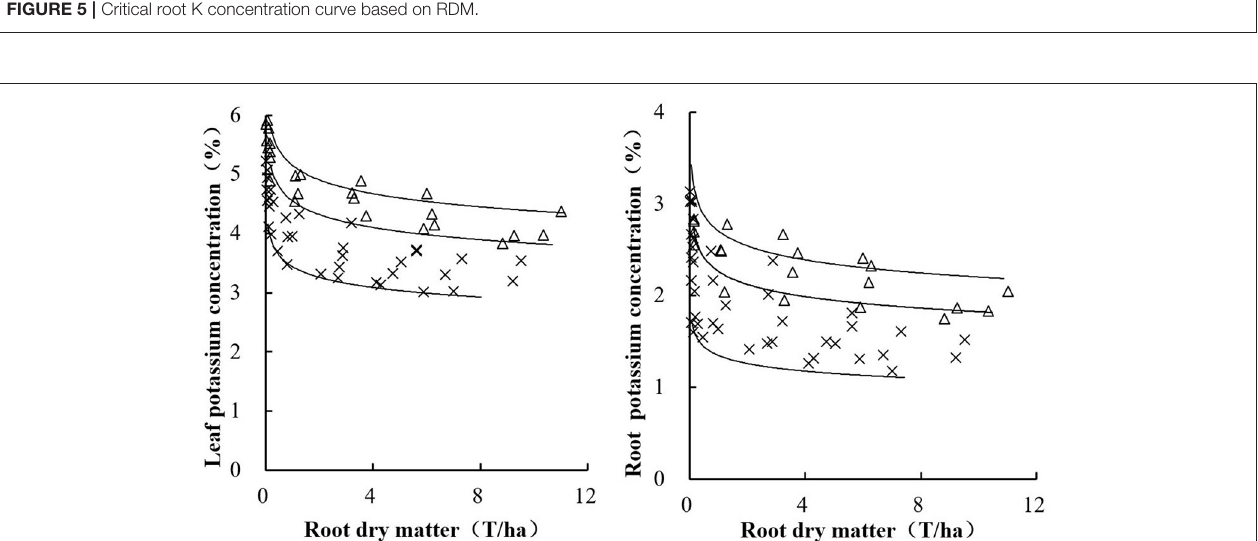
FIGURE 6 | Validation of leaf (left) and root (right) K concentration curves using the independent data set conducted during